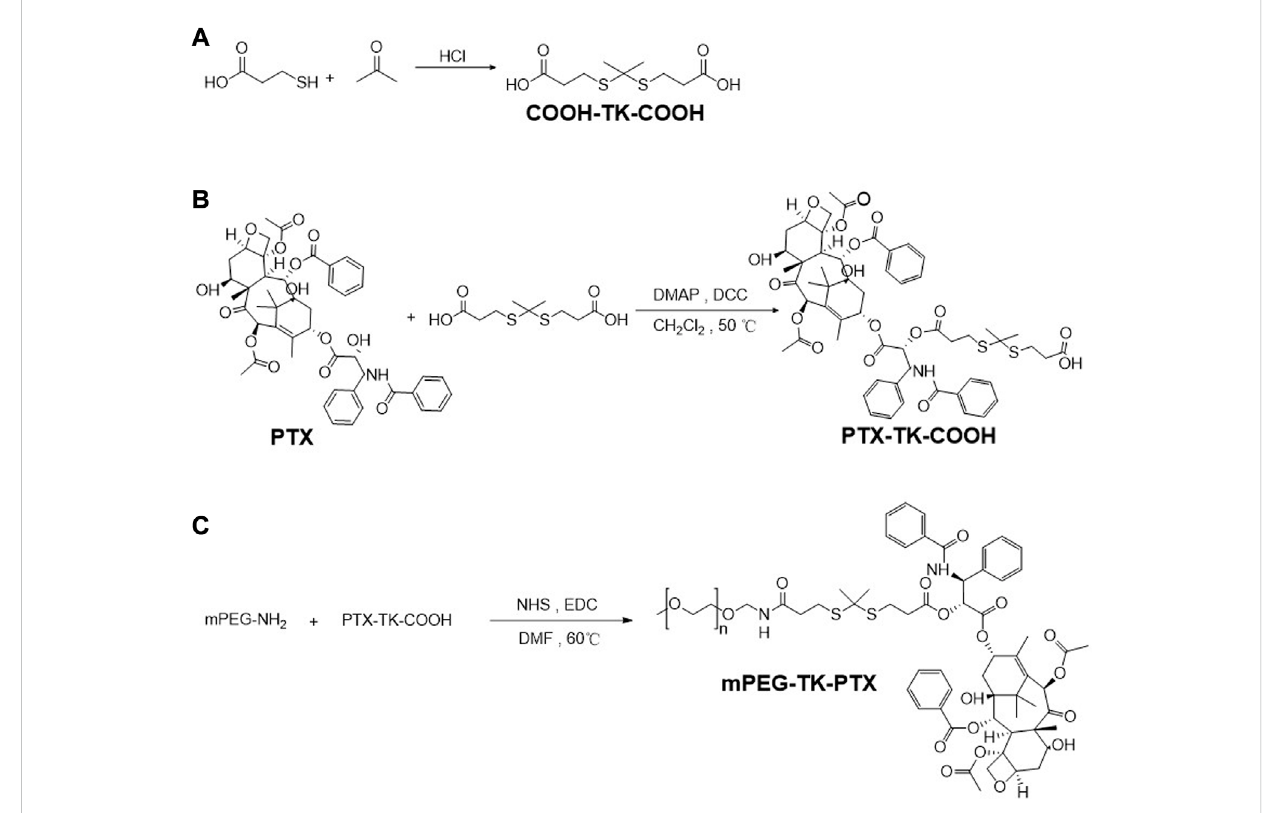
FIGURE 1 The synthesis routs of TK (A) , PTX-TK-COOH (B) , and mPEG-TK-PTX (C) ,